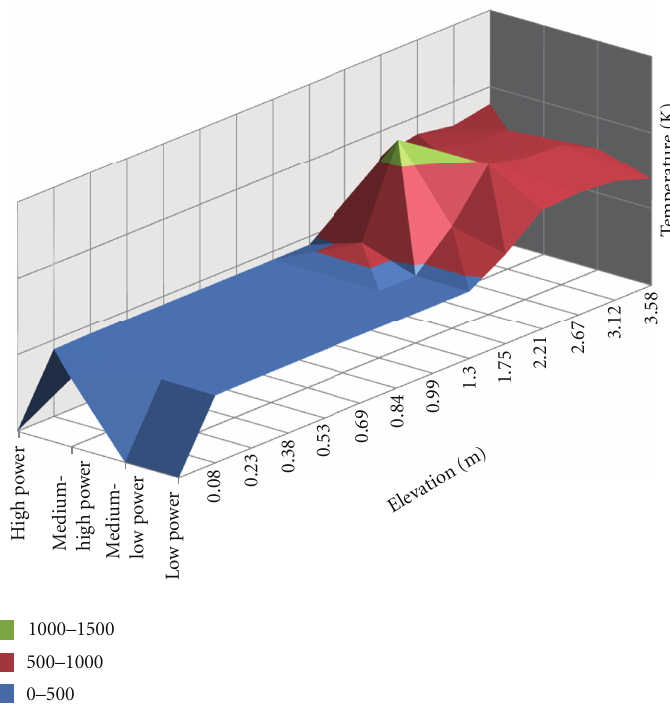
Figure 36: Core temperature distribution at 5.1 hours for scenario with water injection at 4.9 hours after scram (all emergency water injection was terminated at 4.2 hours after reactor